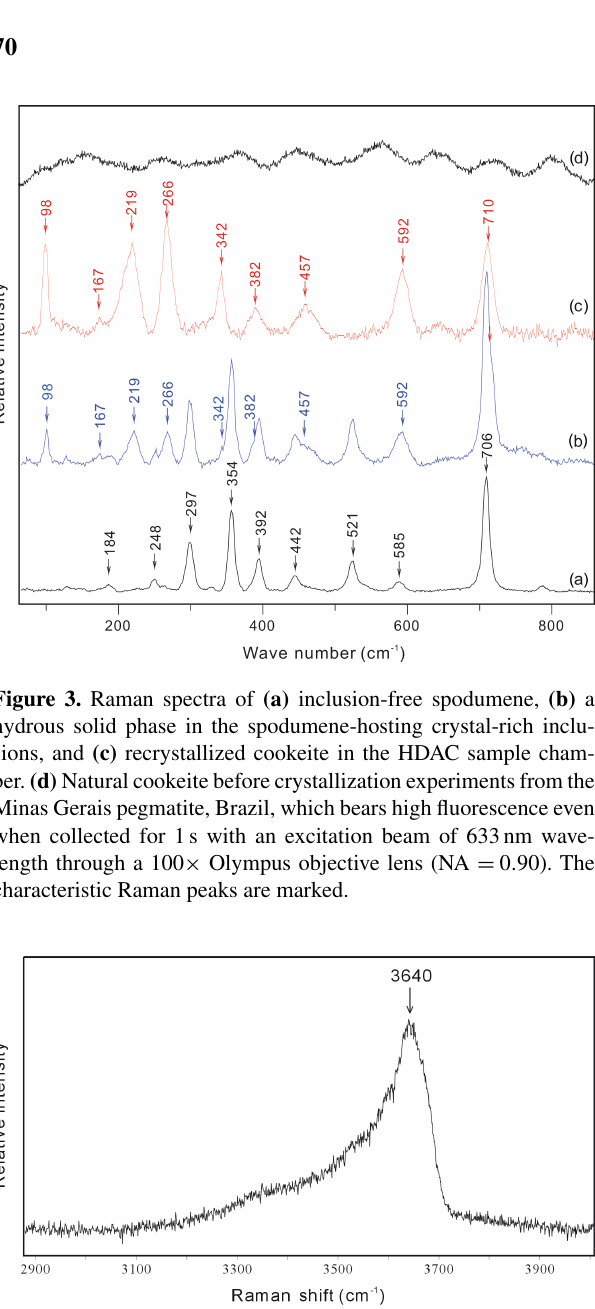
Figure 4. Raman spectrum of the hydrous solid phase cookeite in a spodumene-hosted crystal-rich inclusion in the high wave num- ber region, showing the characteristic peak near 3640cm − 1 in a hydrous sample.